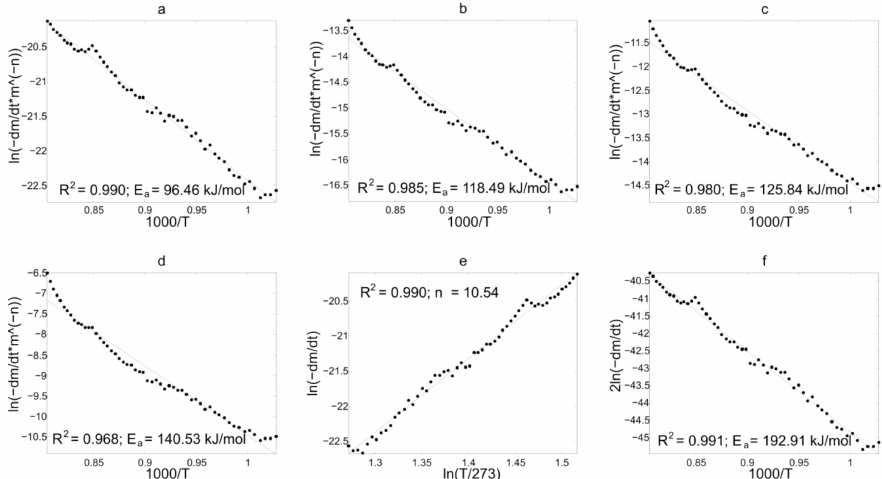
Figure 8. Results of processing of the charcoal gasification TG curve at a heating rate of 20 K min − 1 by different models: ( a ) n = 0; ( b ) n = 0.5; ( c ) n = 2/3; ( d ) n = 1; ( e ) diffusion model; ( f ) pore- diffusion